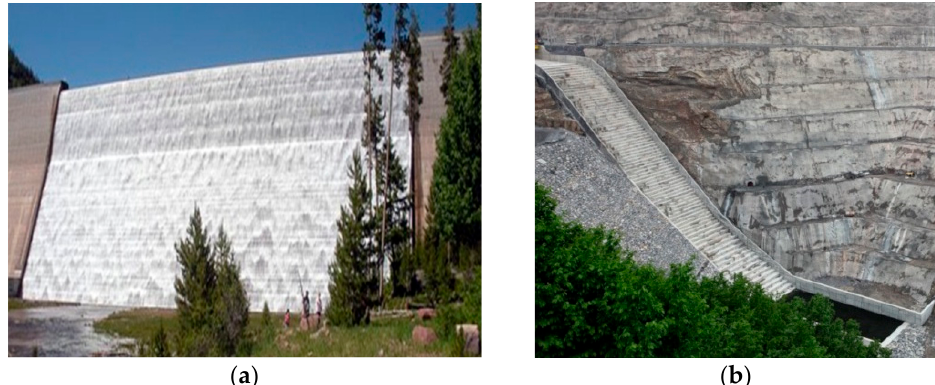
Figure 1. Stepped spillways with an abrupt slope reduction ( a ) Upper Stillwater dam, USA (http://www.usbr.gov, last accessed date: 15 November 2013); ( b ) Siah-Bishe lower dam, Iran (http://www.iwpco.ir, last accessed date: 21 February 2016).